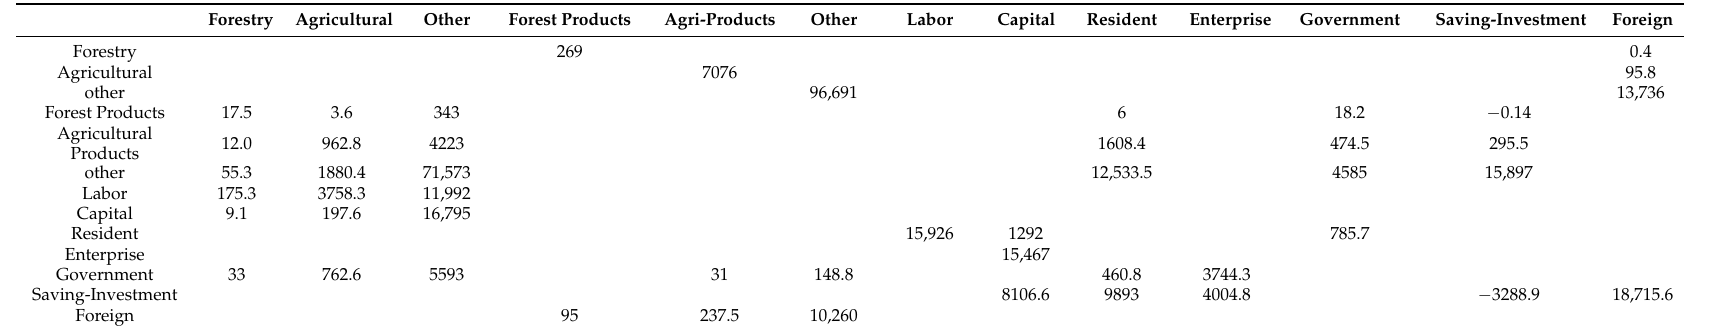
Table 2. Macro social accounting matrix of China (10 8